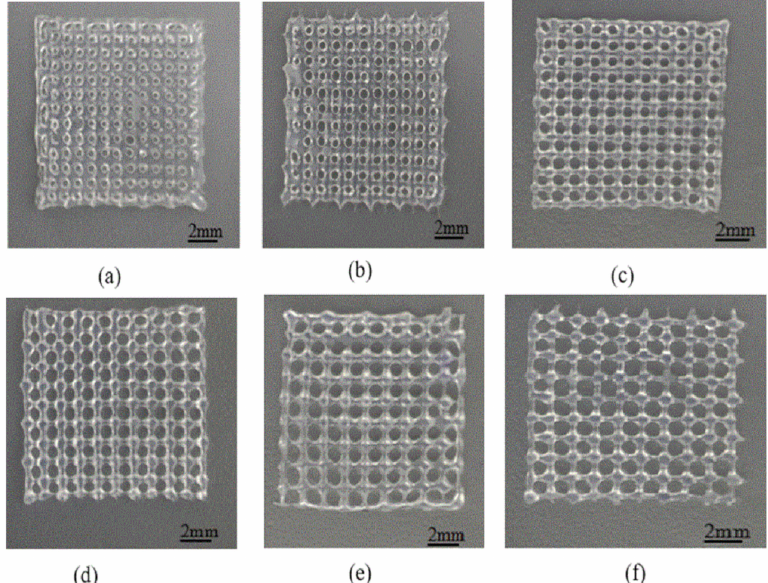
Figure 12. Print sca ff olds at di ff erent intervals. ( a ) sca ff old structure with fiber spacing 0.6 mm; ( b ) sca ff old structure with fiber spacing 0.8 mm; ( c ) sca ff old structure with fiber spacing 1.0 mm; ( d ) sca ff old structure with fiber spacing 1.2 mm; ( e ) Sca ff old structure with fiber spacing 1.4 mm; ( f ) Sca ff old structure with fiber spacing 1.6